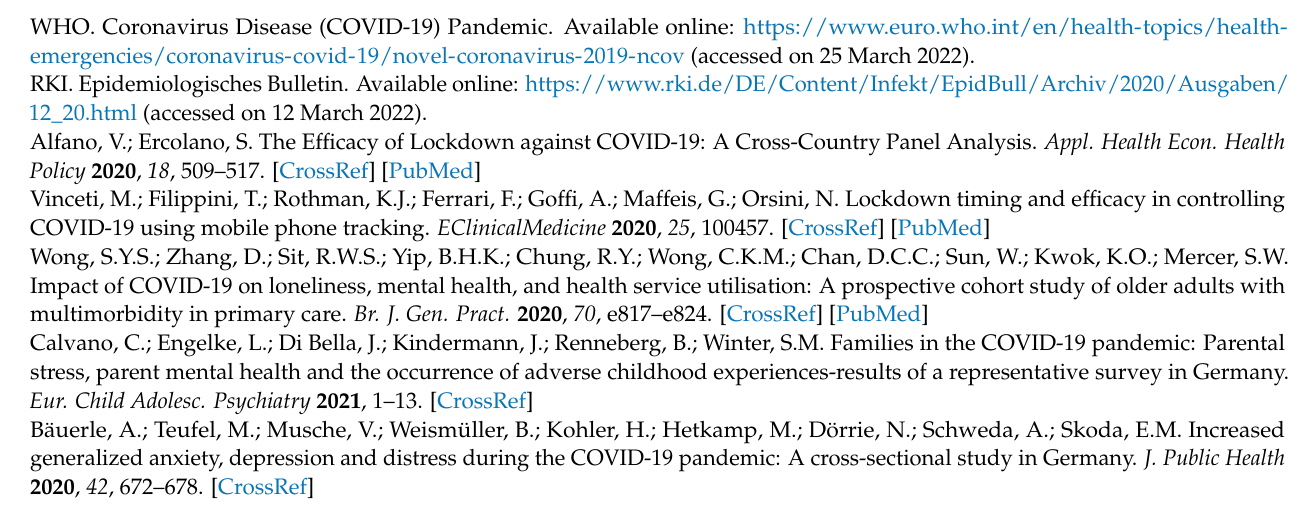
Figure S3. Distribution of residuals from the final regression model of life satisfaction in the group with lower life satisfaction. Figure S4. Scatterplot of residuals of the final regression model in the group with lower life